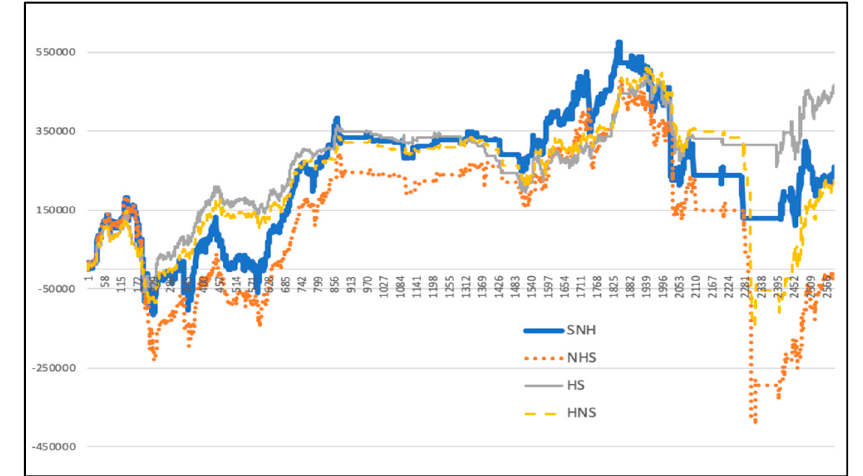
Figure 31. Four strategic income line graphs (25% after forecasting).